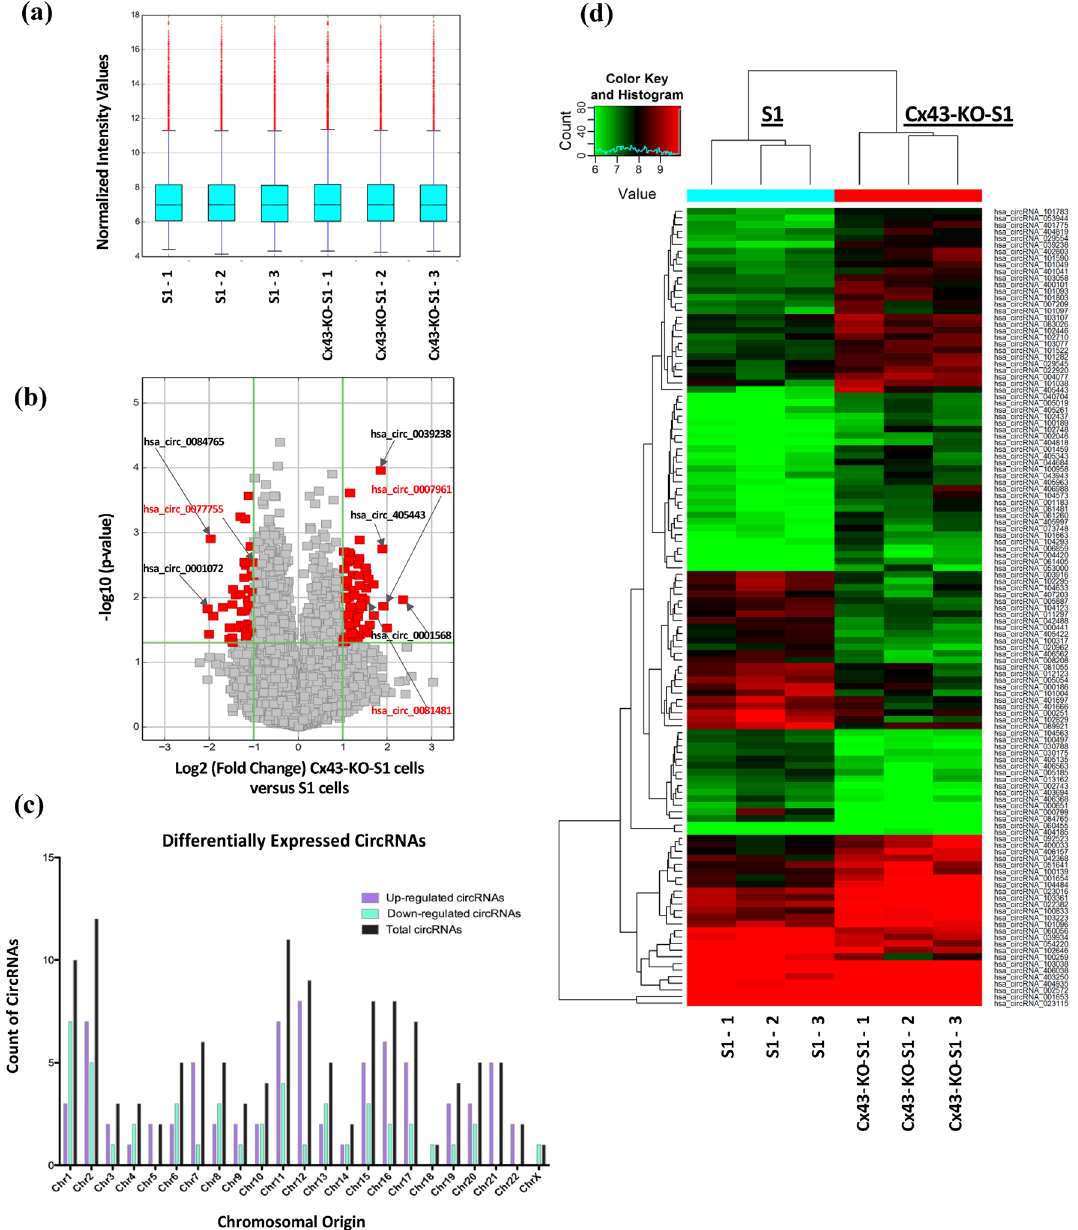
Figure 2. Microarrays revealed 121 differentially expressed circRNAs in response to Cx43 silencing in Cx43- KO-S1 (pretumorigenic) cells versus S1 (nontumorigenic) breast epithelial cells in 3D. Triplicates of Cx43- KO-S1 and triplicates of S1 cells were plated on Matrigel™ for 11 days. Total RNA was extracted, digested with RNase R to remove linear RNAs and enrich circRNAs, reverse transcribed and hybridized to Arraystar Human circRNA Array V2 microarrays. ( a ) Box plot after quantile normalization showing the distributions of log2 ratios among the six samples. ( b ) Volcano plot depicting the differential circRNA expression, with the vertical green lines corresponding to 2.0-fold up and down, and the horizontal green line representing a p-value of 0.05. The red points in the plot represent the differentially expressed circRNAs with statistical significance. The circRNAs denoted in black font with arrows highlight the most up-regulated (right) and down-regulated (left) circRNAs, while the circRNAs denoted in red font with arrows highlight the three chosen and validated circRNAs in this study. ( c ) Bar graph showing the chromosomal distributions of the differentially expressed circRNAs. ( d ) Unsupervised hierarchical cluster analysis (heat map) of microarray data used to assess the significant expression of circRNAs when comparing Cx43-KO-S1 to S1 cells in 3D (the key range (6–10) represents the log2 value of the normalized intensity for each sample and not the fold change). “Red” indicates higher expression level, and “green” indicates lower expression level in Cx43-KO-S1 as compared to S1 cells. Each circRNA is represented by a single row of colored boxes and each sample is represented by a single